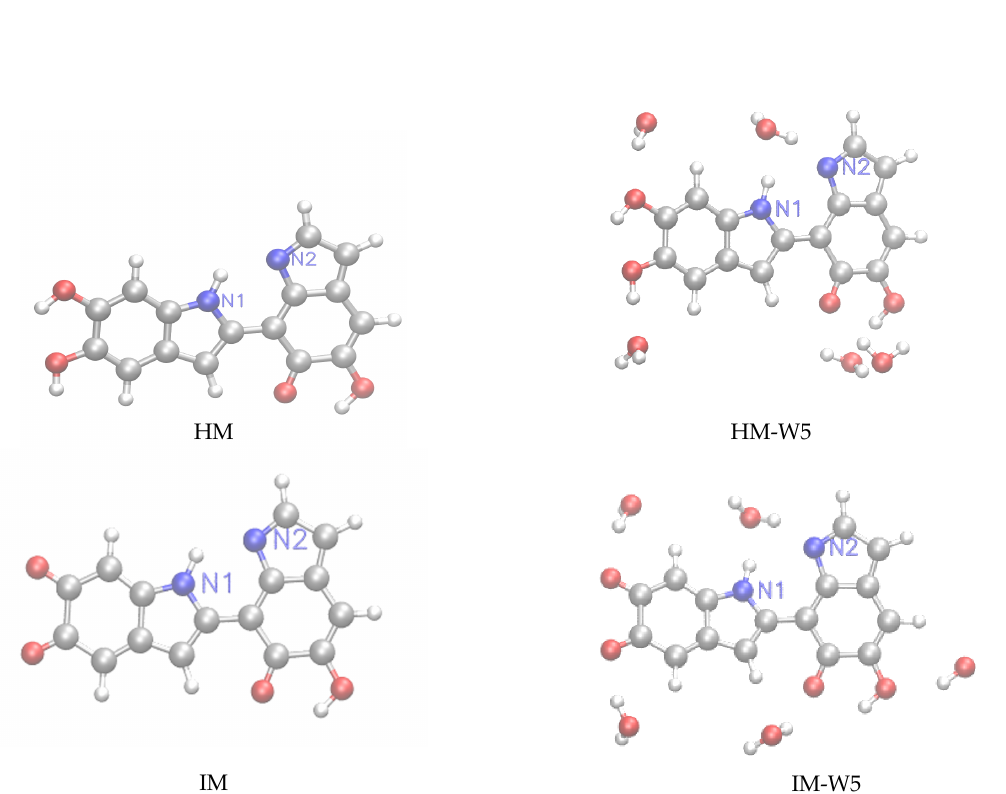
Figure 2. Left panels: structure of the HM ≡ HQ+MQ and IM ≡ IQ+MQ dimers. Right panels: microsolvated structures with five water molecules (HM-W5,